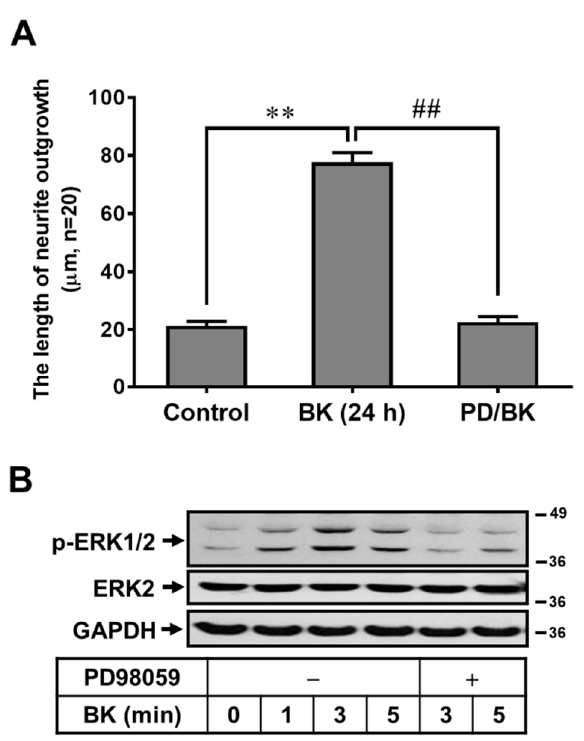
Figure 4. The ERK1/2 participates in BK-induced RBA morphological change into neuron-like cells. ( A ) RBA cells were pretreated with PD98059 (10 μ M) for 1 h and then incubated with or without BK (10 nM) for 24 h. The phase-contrast images were obtained and the length of neurite fiber outgrowth at 24 h was quantified. ( B ) Cells were pretreated without or with BK (10 nM) for the indicated times. The whole-cell lysates were subjected to 10% SDS-PAGE and analyzed using an anti-phospho-ERK1/2, anti-ERK2, or anti-GAPDH (as an internal control) antibody, as described under ‘‘Methods’’. The image represents one of at least three individual experiments. Data are expressed as the mean ± SEM of at least three independent experiments. ** p < 0.01, as compared with control. ## p < 0.01, as compared with BK alone.